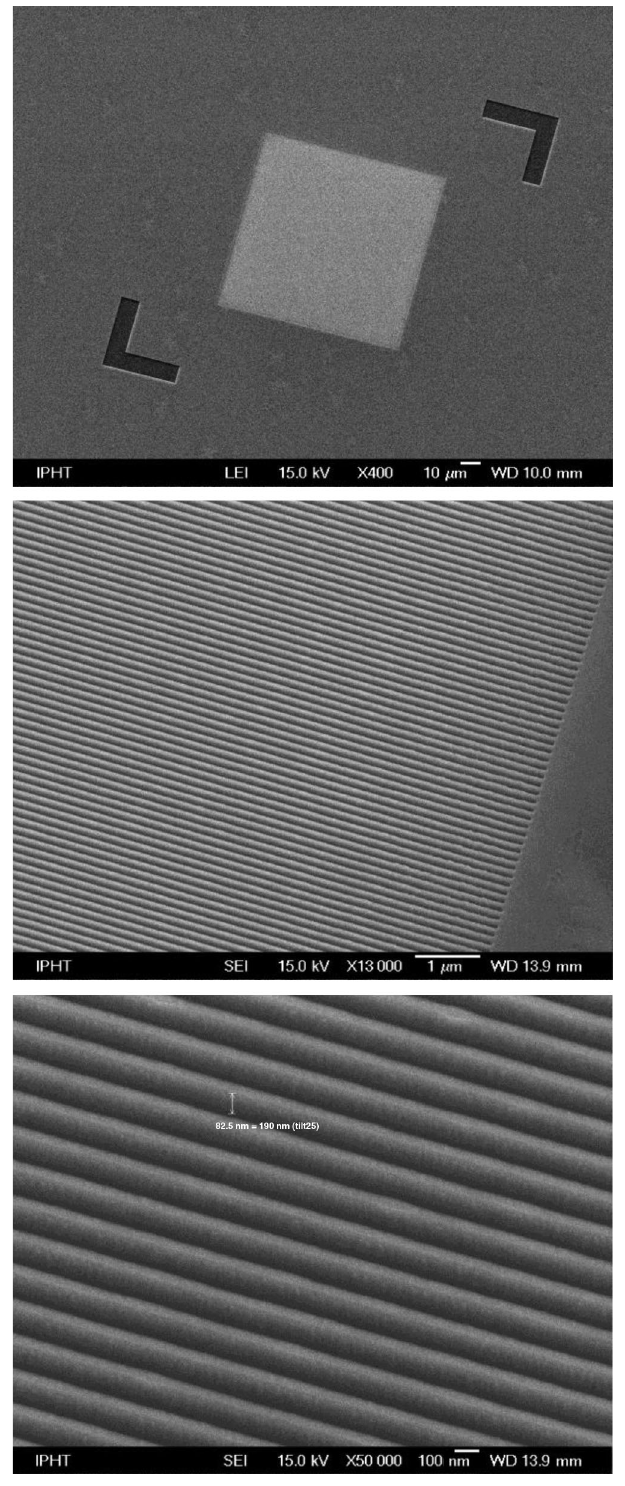
FIG. 6. Electron microscope images of a sample target ( g ¼ 200 nm) at three different zoom